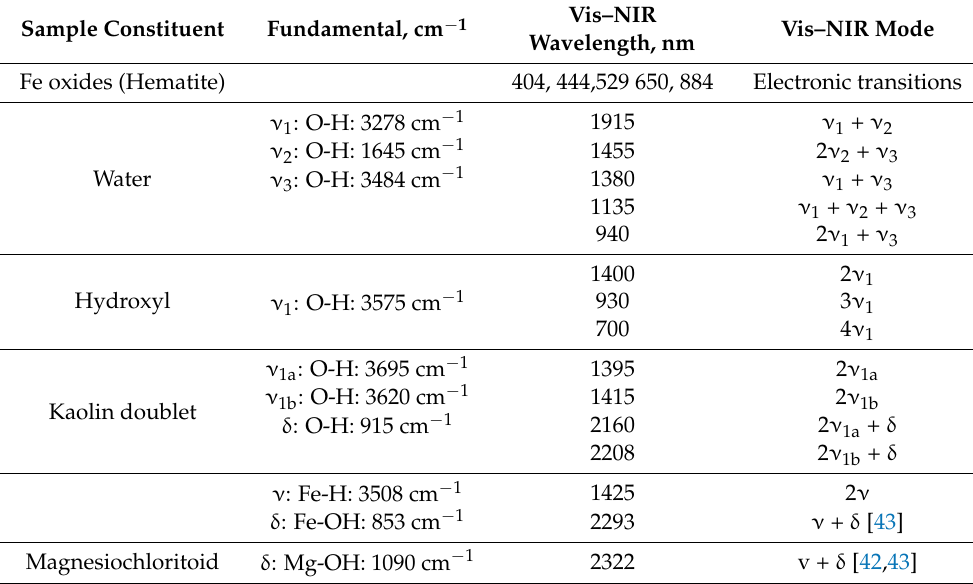
Table 3. Band assignments for fundamental mid-IR absorption of red clay constituents and their overtone and combinations in the Vis–NIR [38,40–42]. For the sake of simplicity, some selected wavelengths were not represented in Figure